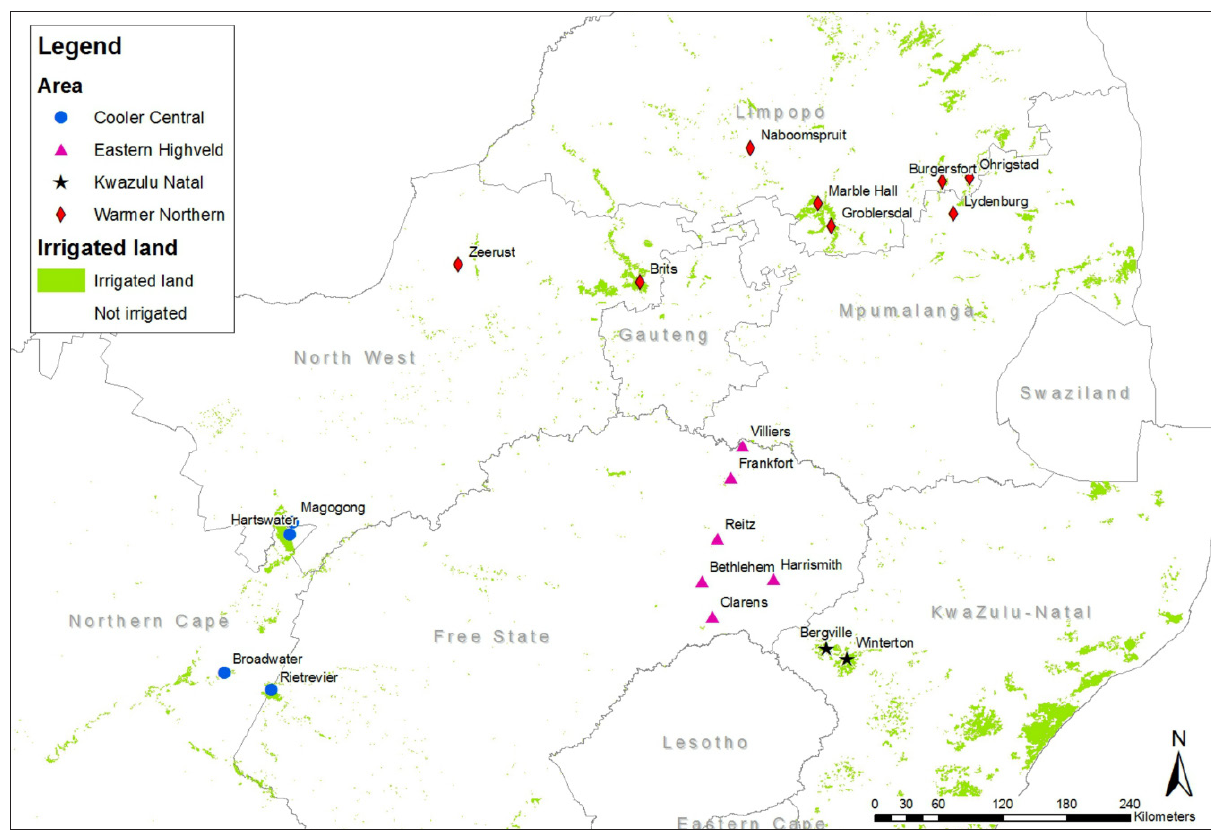
Figure 1: The major irrigation wheat production regions of South